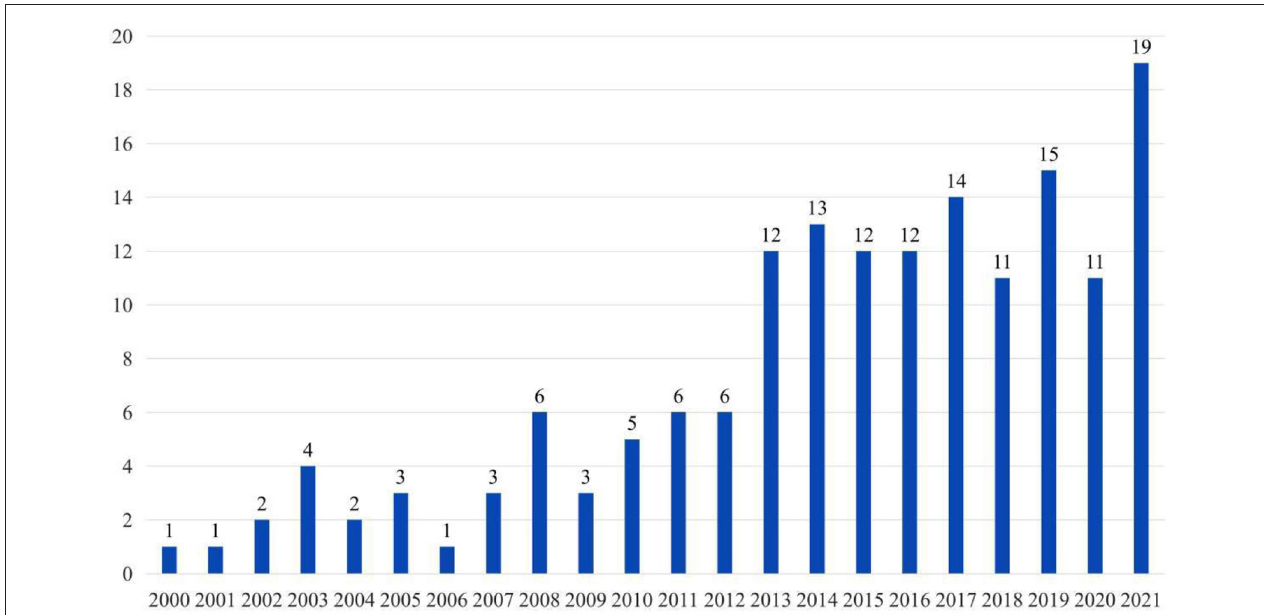
FIGURE 2 | Time trend of publications on volunteer motivation.